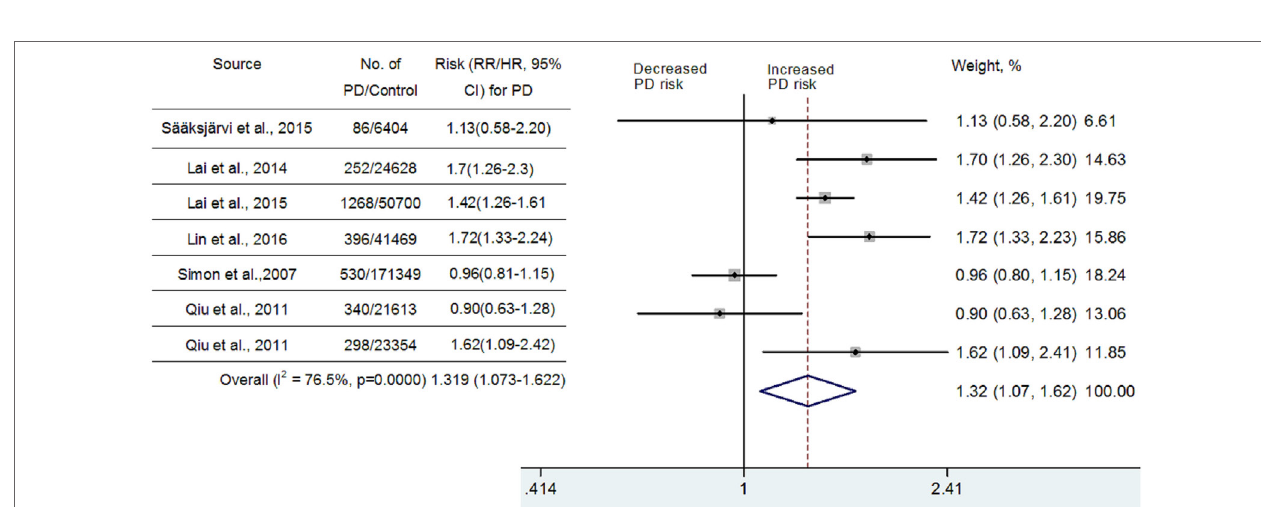
FigURe 2 | Meta-analysis of the association between hypertension and Parkinson’s disease (PD)